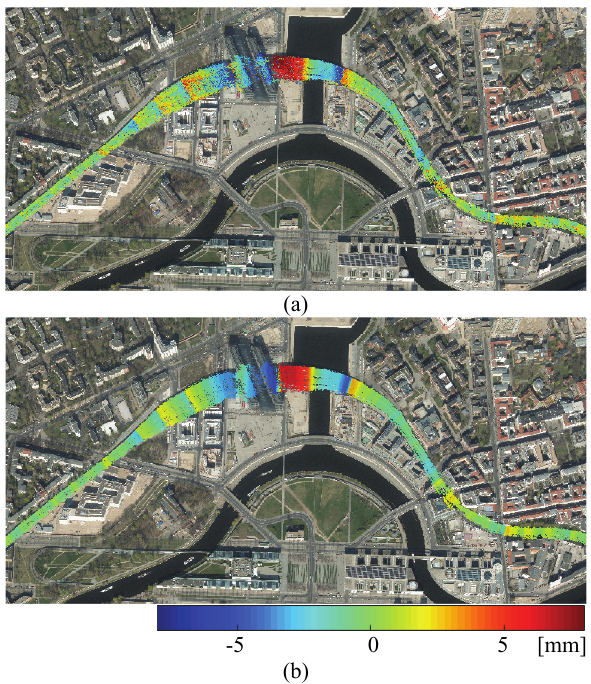
Figure 13. (a) Railway points extracted from the TomoSAR point cloud. The color shows the amplitude of seasonal motion due to the thermal expansion of the steel, and (b) denoised deformation estimates using minimization of total